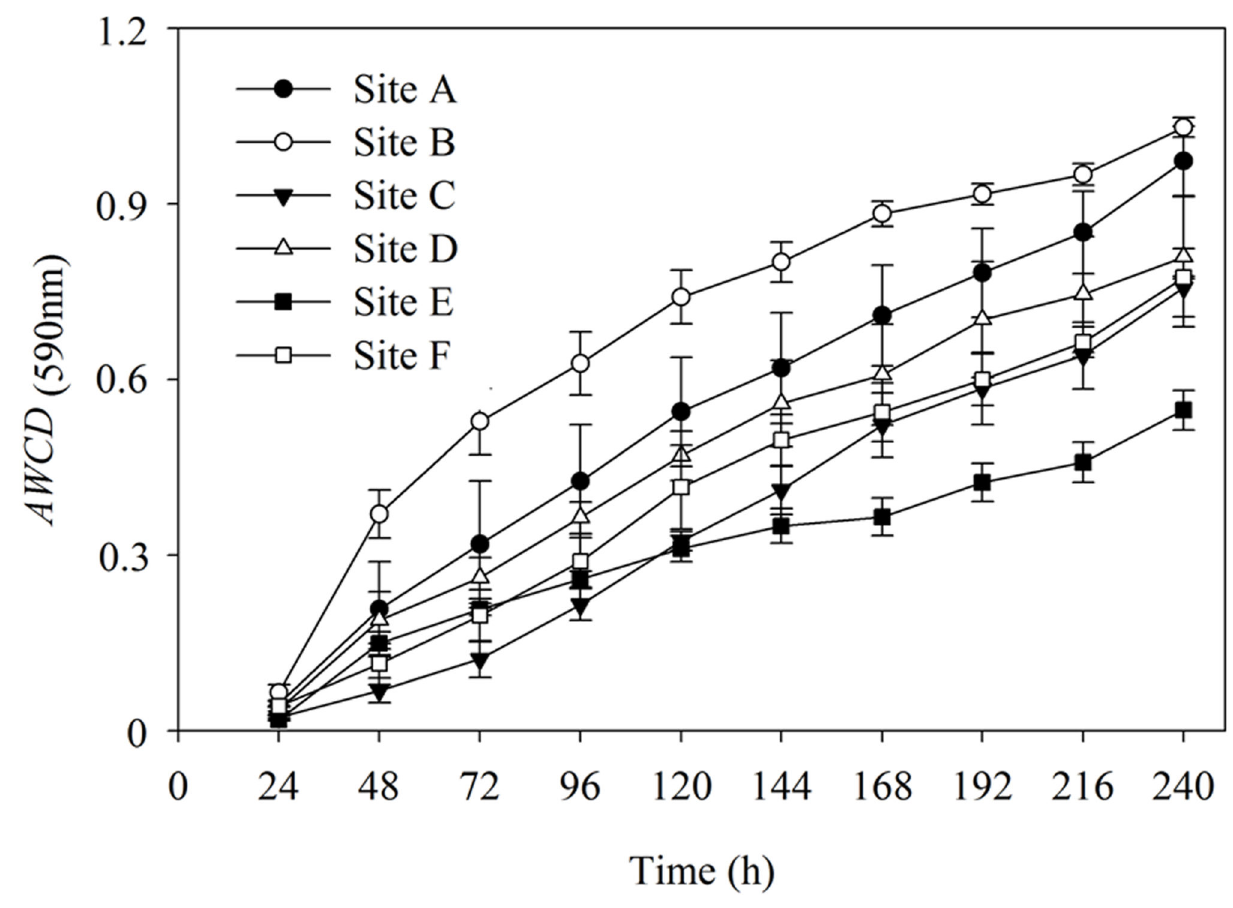
Figure 1. Kinetics of average well color development ( AWCD were collected from each six sampling sites (site A, site B, site C, site D, site E, site F). The data shown are the means and standard error (S.E) ( n